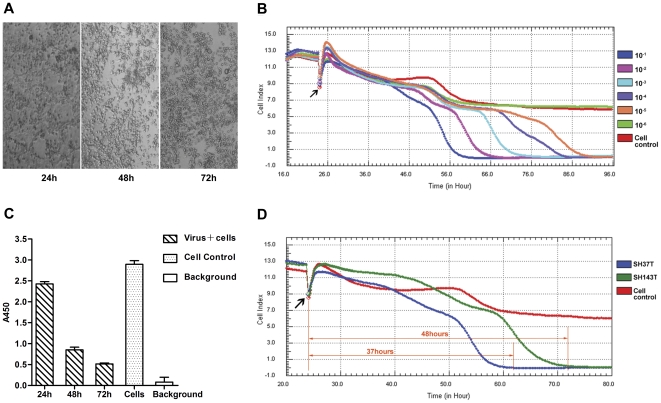
Real-time monitoring of pH1N1 virus-mediated cytopathogenicity.A) The CPE on MDCK cells infected with SH37T (1∶10 diluted) at 24, 48, and 72 hours post-infection. B) Real-time monitoring of the CPE on MDCK cells infected with SH37T using the RTCA system. The curve was an average of four independent replicate wells. At the indicated time point the cells were inoculated with different dilutions of virus. C) The colorimetric assays for the CPE on MDCK cells infected with SH37T (1∶10 diluted). OD values at A450 obtained at 24, 48, and 72 hours post-infection are shown. Error bars indicate standard deviation. D) Difference in CPE kinetic patterns between SH37T and SH143T with the same infectious vial load of 5.50×107 copies/mL. The plotted lines indicate the different time points when the CI declined to 0 between stains.